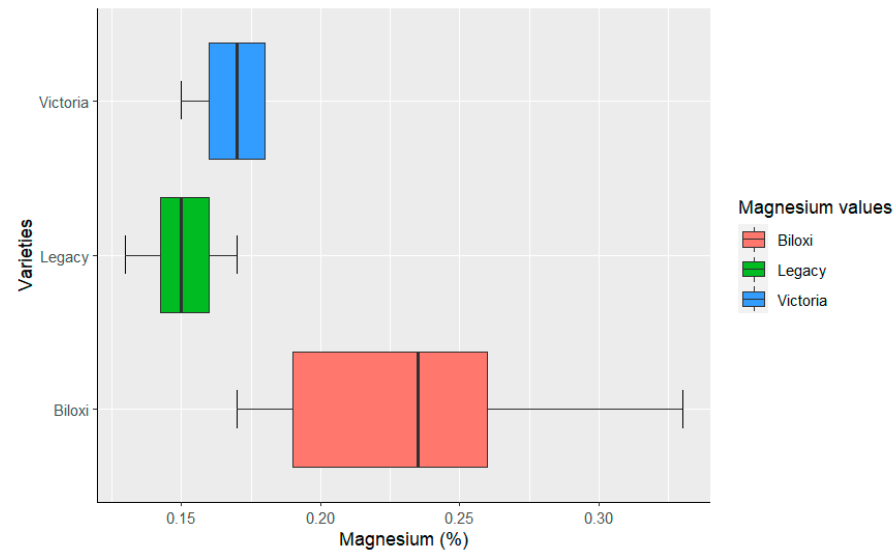
Figure 3. Box-plot of the foliar Magnesium content in Biloxi, Legacy and Victoria variety Blueberry plants cultivated under conditions of the Colombian high tropics.